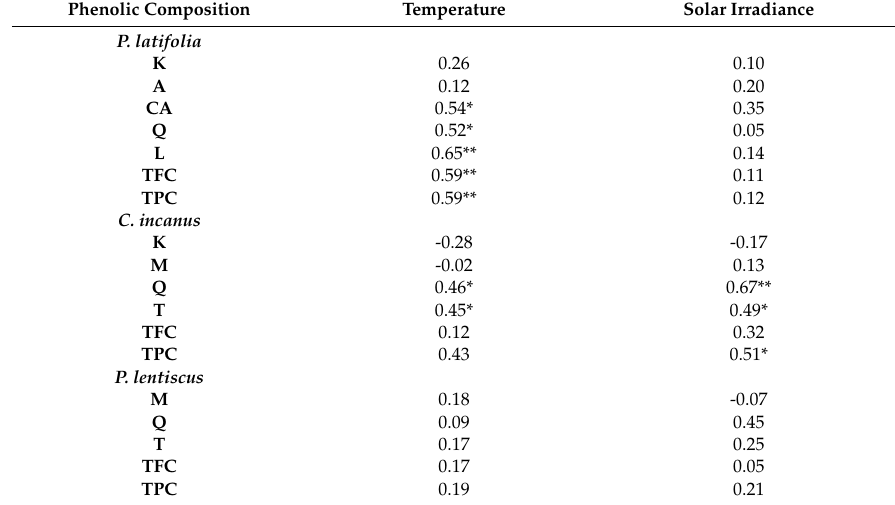
Table 1. Correlation (Pearson coe ffi cient— r ) between phenolic composition and environmental data (temperature and solar irradiance) for the three studied species ( Phillyrea latifolia , Cistus incanus and Pistacia lentiscus